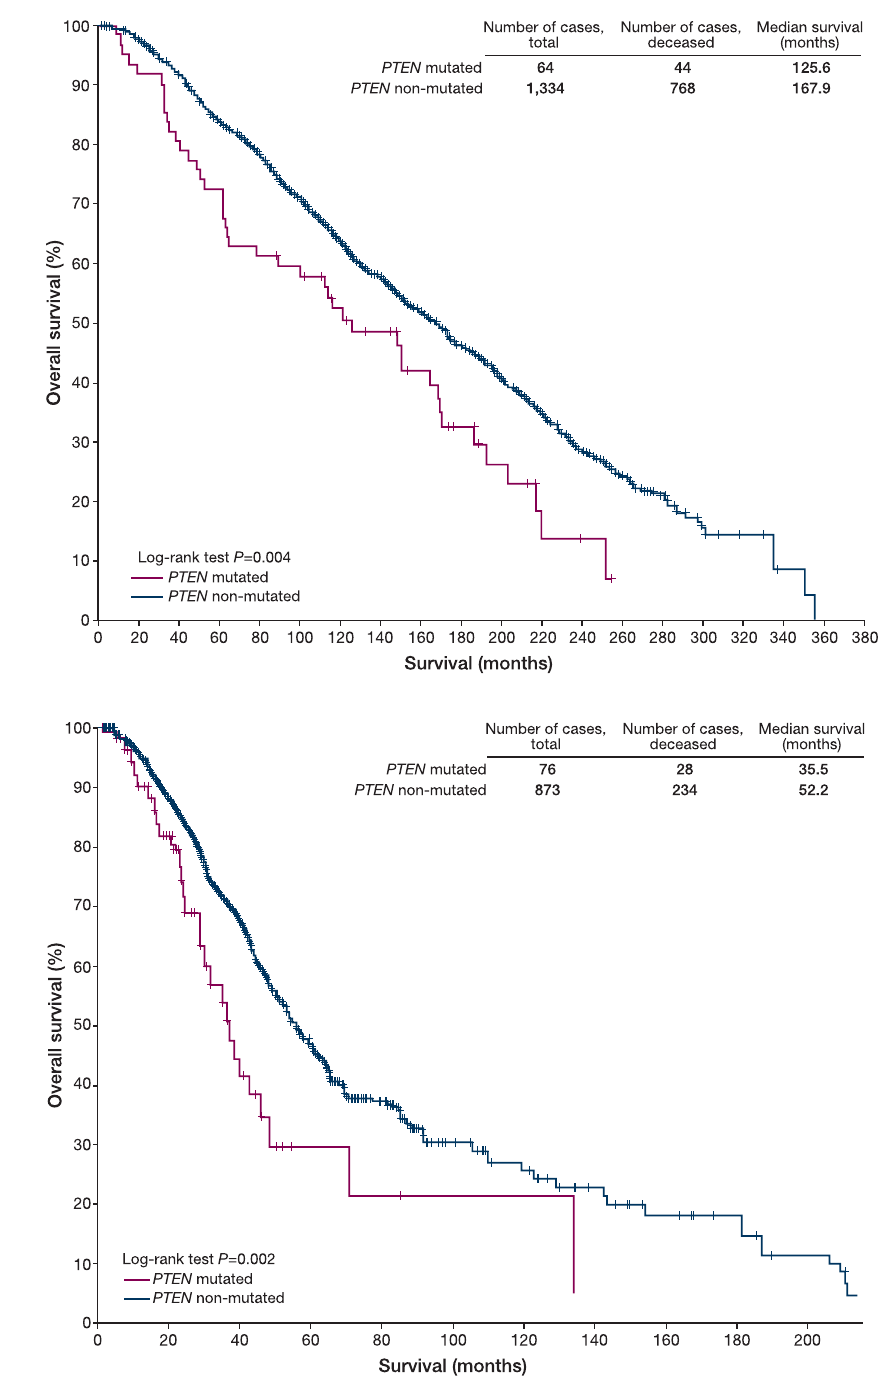
Fig. 1 PTEN mutations are associated with a poor prognosis in ER + HER2 – breast cancer. a Early-stage ER + HER2 – breast cancers (METABRIC data) 19 . b Metastatic ER + HER2 – breast cancers (MSK-IMPACT data) 12 . Kaplan – Meier survival analysis for ER + HER2 – breast cancer patients by PTEN status in early-stage and metastatic BC: a overall survival of patients with ER + HER2 – primary breast tumors ( n = 1398) by PTEN mutation status, using the same criteria employed in this study for enrollment; b overall survival from time of metastatic recurrence of patients with metastatic ER + HER2 – breast cancer ( n = 949) by PTEN status. A patient with multiple metastatic samples sequenced by next- generation sequencing was considered PTEN altered if at least one sample harbored an eligible PTEN alteration. Overall survival for the METABRIC data utilized univariable or multivariable Cox proportional hazards models to examine the association between mutations and survival. Breast cancer-speci fi c survival was used as the endpoint. Patients with deaths from other or unknown causes were censored at the date of death, and all other patients were censored at the date of last contact 19 . Overall survival for the MSK-IMPACT data, as de fi ned by time of metastatic recurrence until death or last follow-up, was analyzed utilizing the MSK cohort 12 restricted to patients with metastatic ER + /HER2 – disease ( n = 949 patients). Univariate P values were calculated using the log-rank test. The models were further adjusted using left truncation methods 37 for late entry when tumor sequencing to assess PTEN status was performed after metastatic recurrence. ER + estrogen- receptor-positive, HER2 – human epidermal growth factor receptor